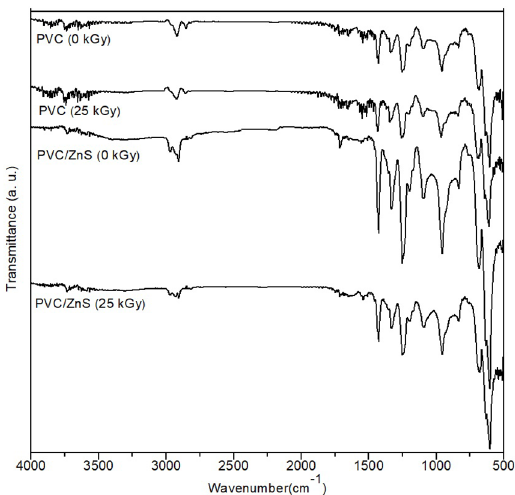
Figure 6. FT-IR spectra for PVC and PVC/ZnS (0.7 %wt) irradiated and unirradiated.